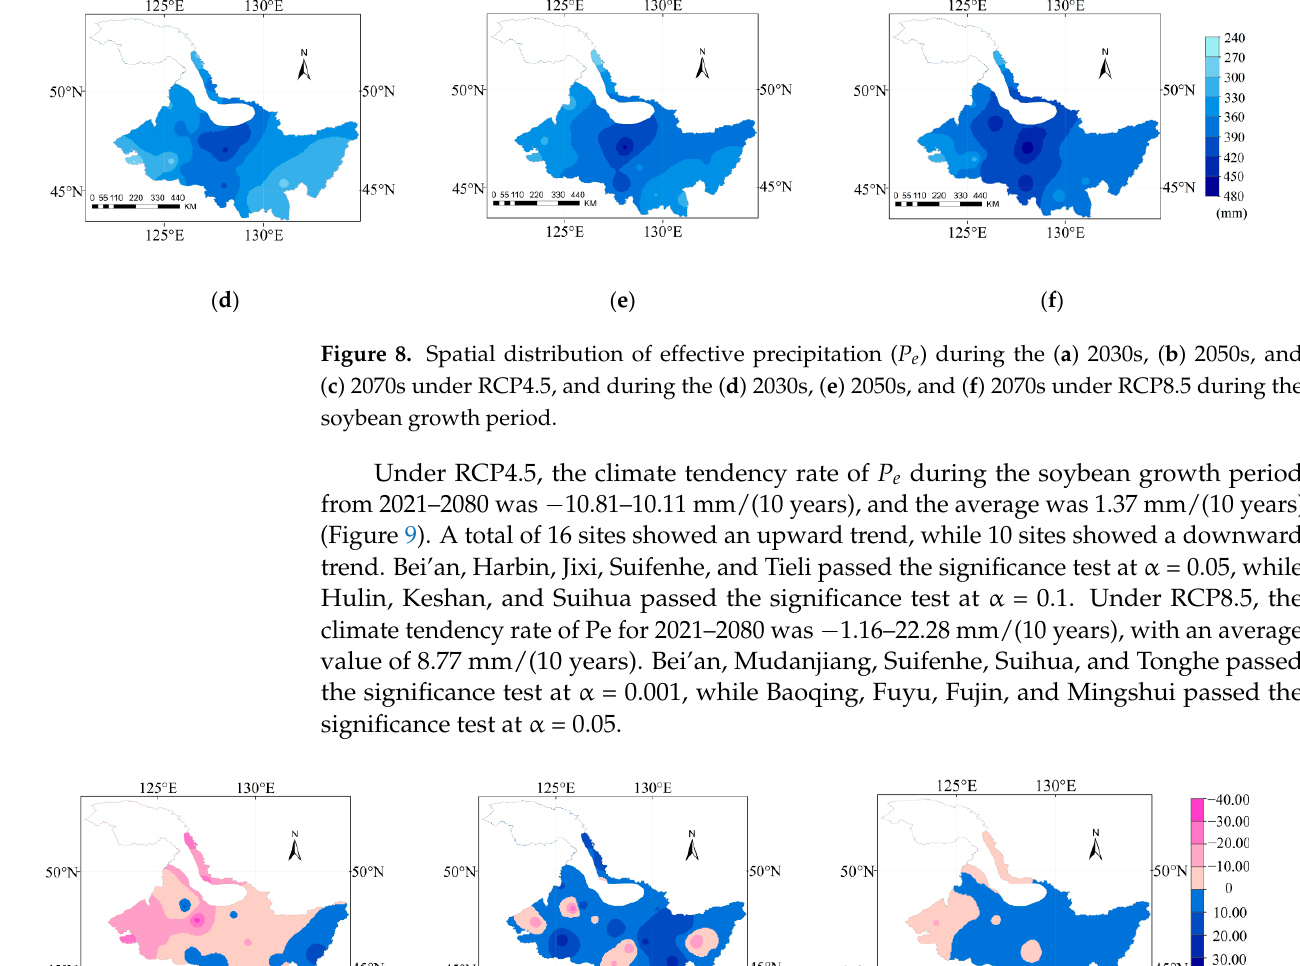
Figure 9. Climate tendency rates of P e in the periods ( a ) 2021–2050, ( b ) 2051–2080, and ( c ) 2021–2080 under RCP4.5, and in the periods ( d ) 2021–2050, ( e ) 2051–2080, and ( f ) 2021–2080 under RCP8.5 during the soybean growth period.